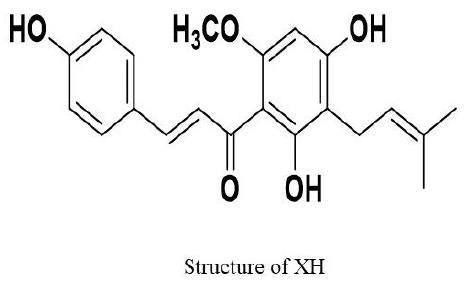
Figure 1. The chemical structure of XH.